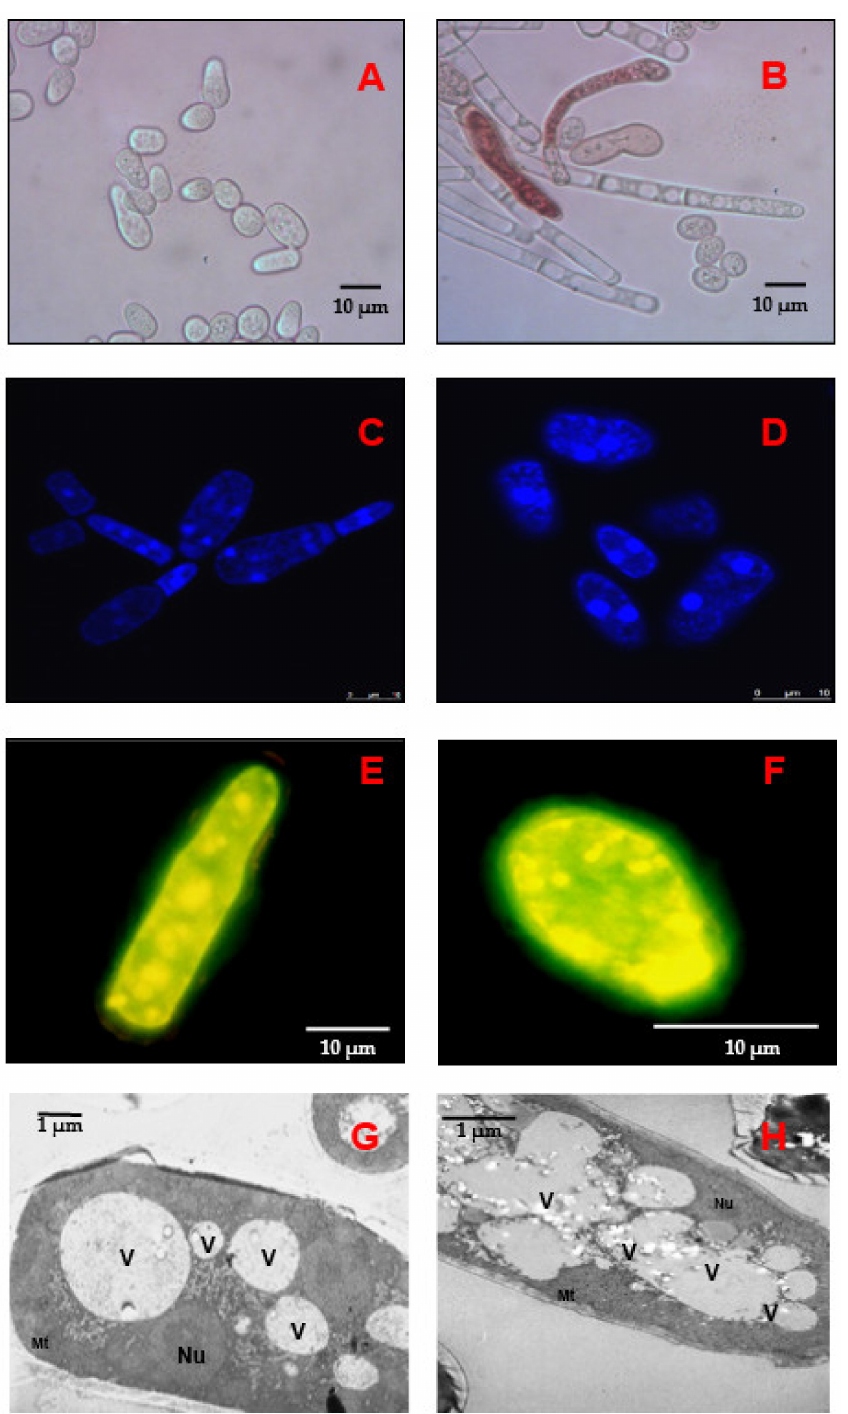
Figure 2. Micro images of the E. magnusii cells in the logarithmic ( A , C , E , G ) and late stationary ( B , D , F , H ) growth stages. ( A , B )—The cells were stained with neutral red; ( C , D ). Fluorescent micro- images of the cells, labelled with 0.3 µ M DAPI for DNA. ( E , F ) the potential-dependent stain of the mitochondria in E. magnusii cells by 5 mM JC-1. The regions of high mitochondrial polarization are bright yellow due to the concentrated dye. The cells were examined after 30 min. The incubation medium contained 0.01 M phosphate buffer saline (PBS) and 1% glycerol, pH 7.4. To examine the Rh123-stained preparations, filters 02, 15 (Zeiss) were used (magnification 100 × ). Photos were taken using an AxioCam MRc camera. ( G , H )-ultrastructure of E. magnusii cells. Nu—nucleus; V—vacuole; Mt–mitochondria; CW–cell